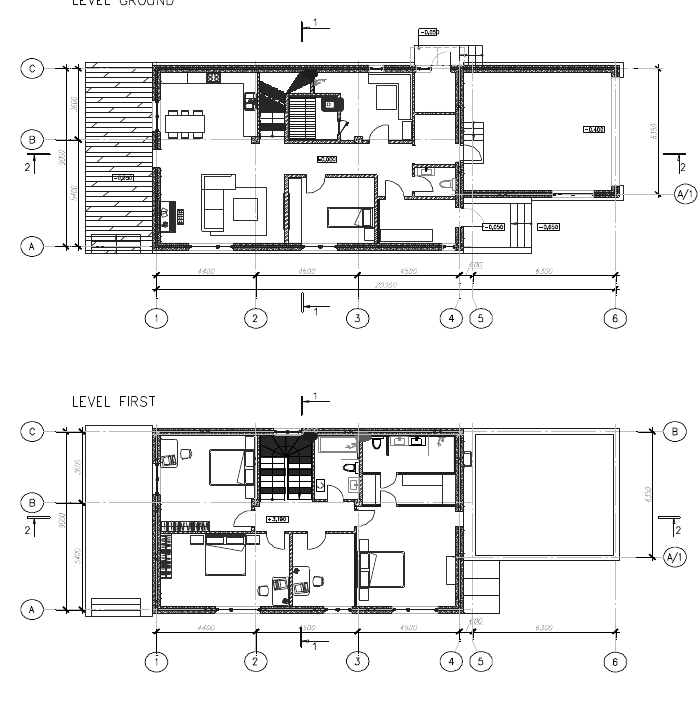
Figure 2. Typical single family